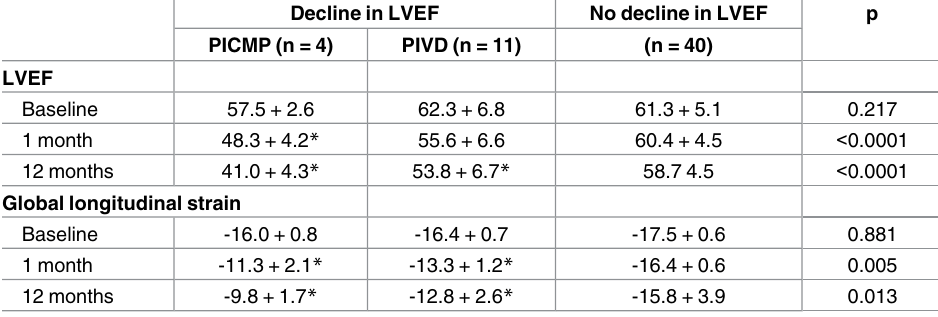
* denotes significantly reduced compared to baseline measurement (p <